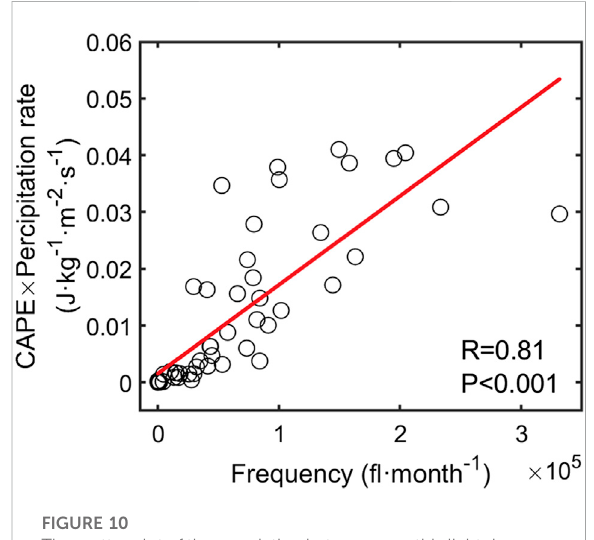
FIGURE 10 Thescatter plotofthecorrelationbetweenmonthly lightning frequency and CAPE×P on the Yungui Plateau from 2016 to